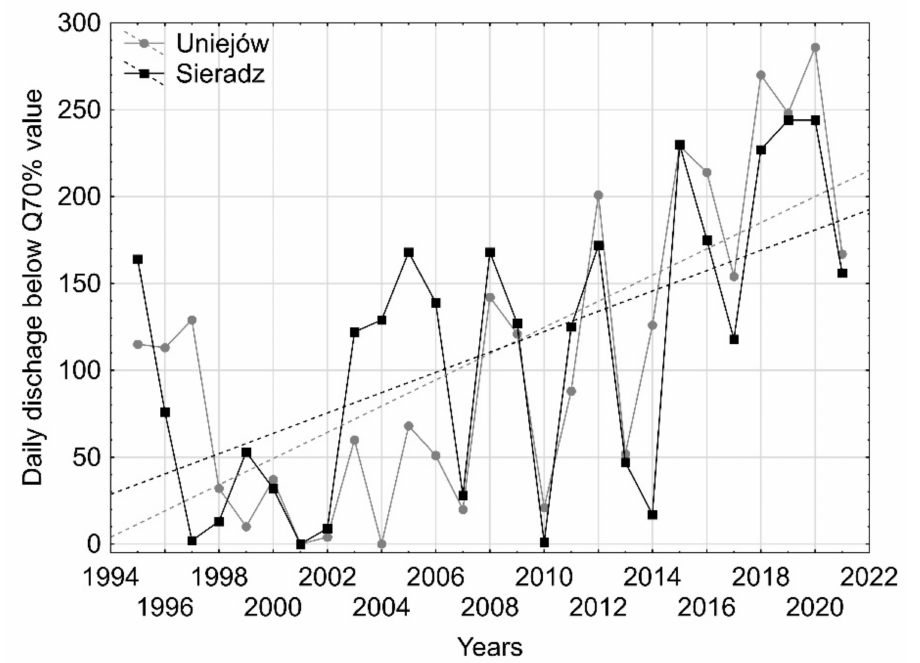
Figure 10. Changes in the durations of flows below the value of Q70% in the Warta River in hydrological stations Sieradz and Uniej ó w in the years